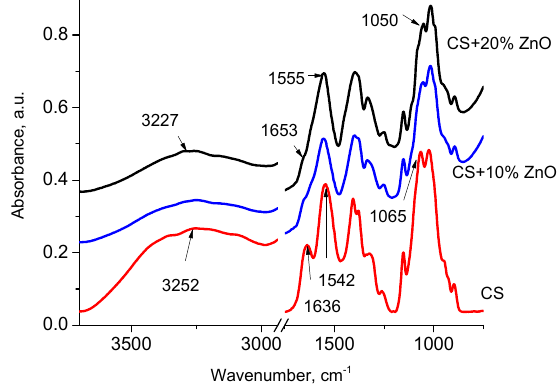
Figure 2. FTIR spectra of neat CS films and CS-ZnO films with 10 and 20 wt.% of ZnO.